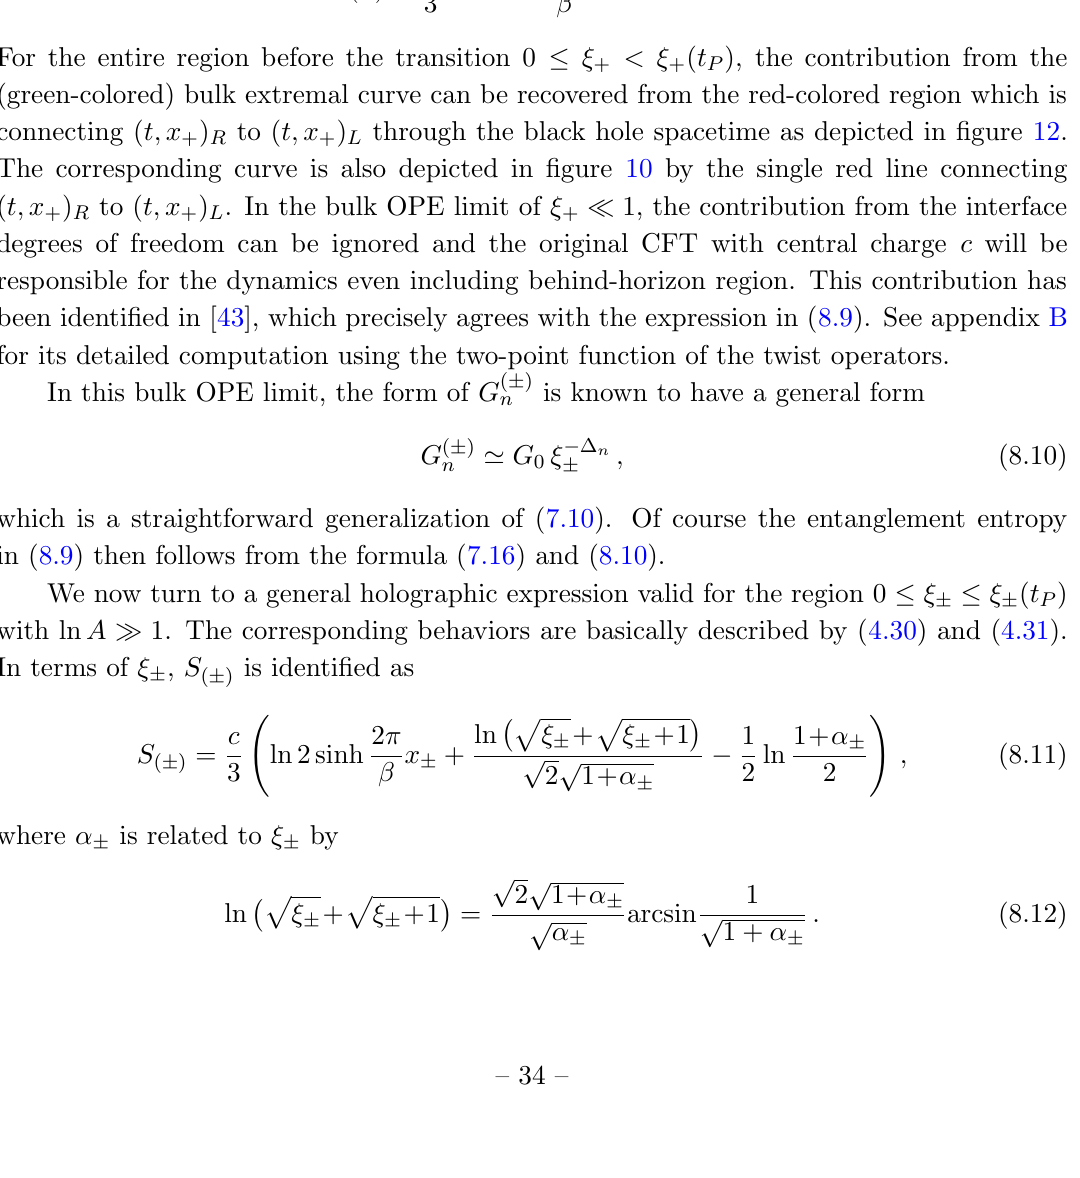
1. On the right side we depict the RL extremal curve just (cid:28)